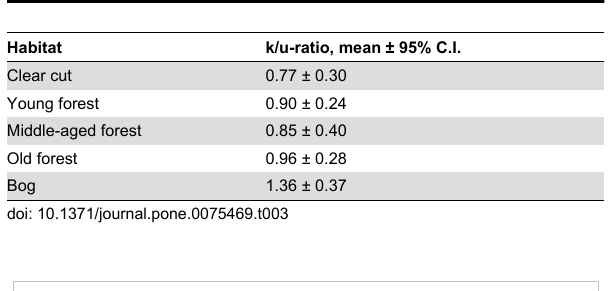
Table 3. Estimates of habitat-specific risk of lynx predation at the spatial and temporal scales of home-ranges and seasons at Grimsö Wildlife Research Area in 1997-2007.